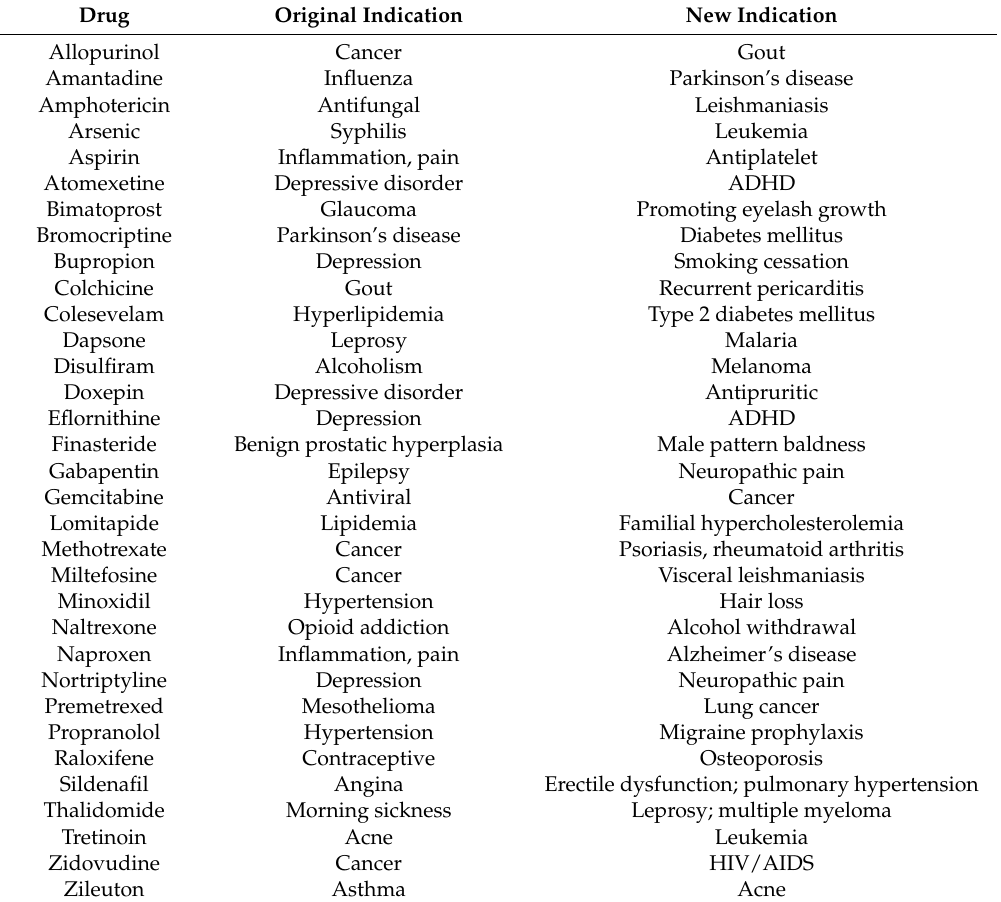
Table 1. Examples of repositioned drugs (adapted in part from [11], this list is neither extensive nor